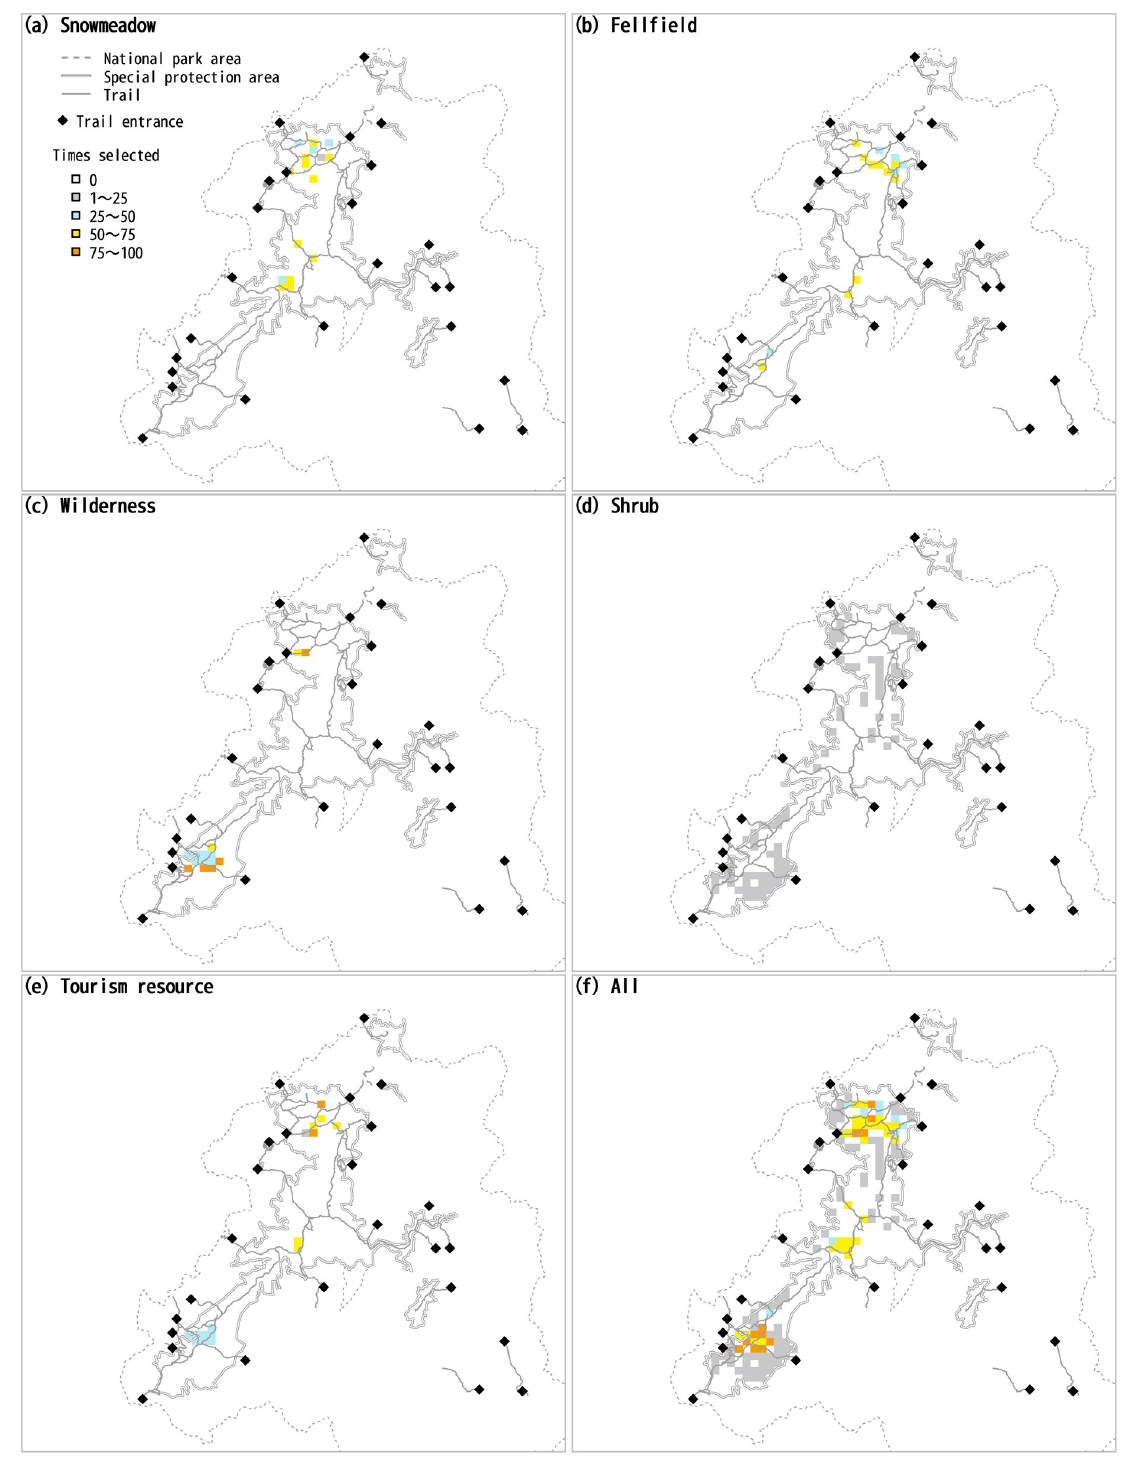
Fig 4. Frequency of selection of each site as areas for conservation of each type of vegetation, for tourism, and for all types of vegetation together. The national park area was drawn based on information provided by the Ministry of Land, Infrastructure, Transport and Tourism [14], and the trails were drawn based on information provided by the Ministory of the Environment [15] under a CC BY license with permission.